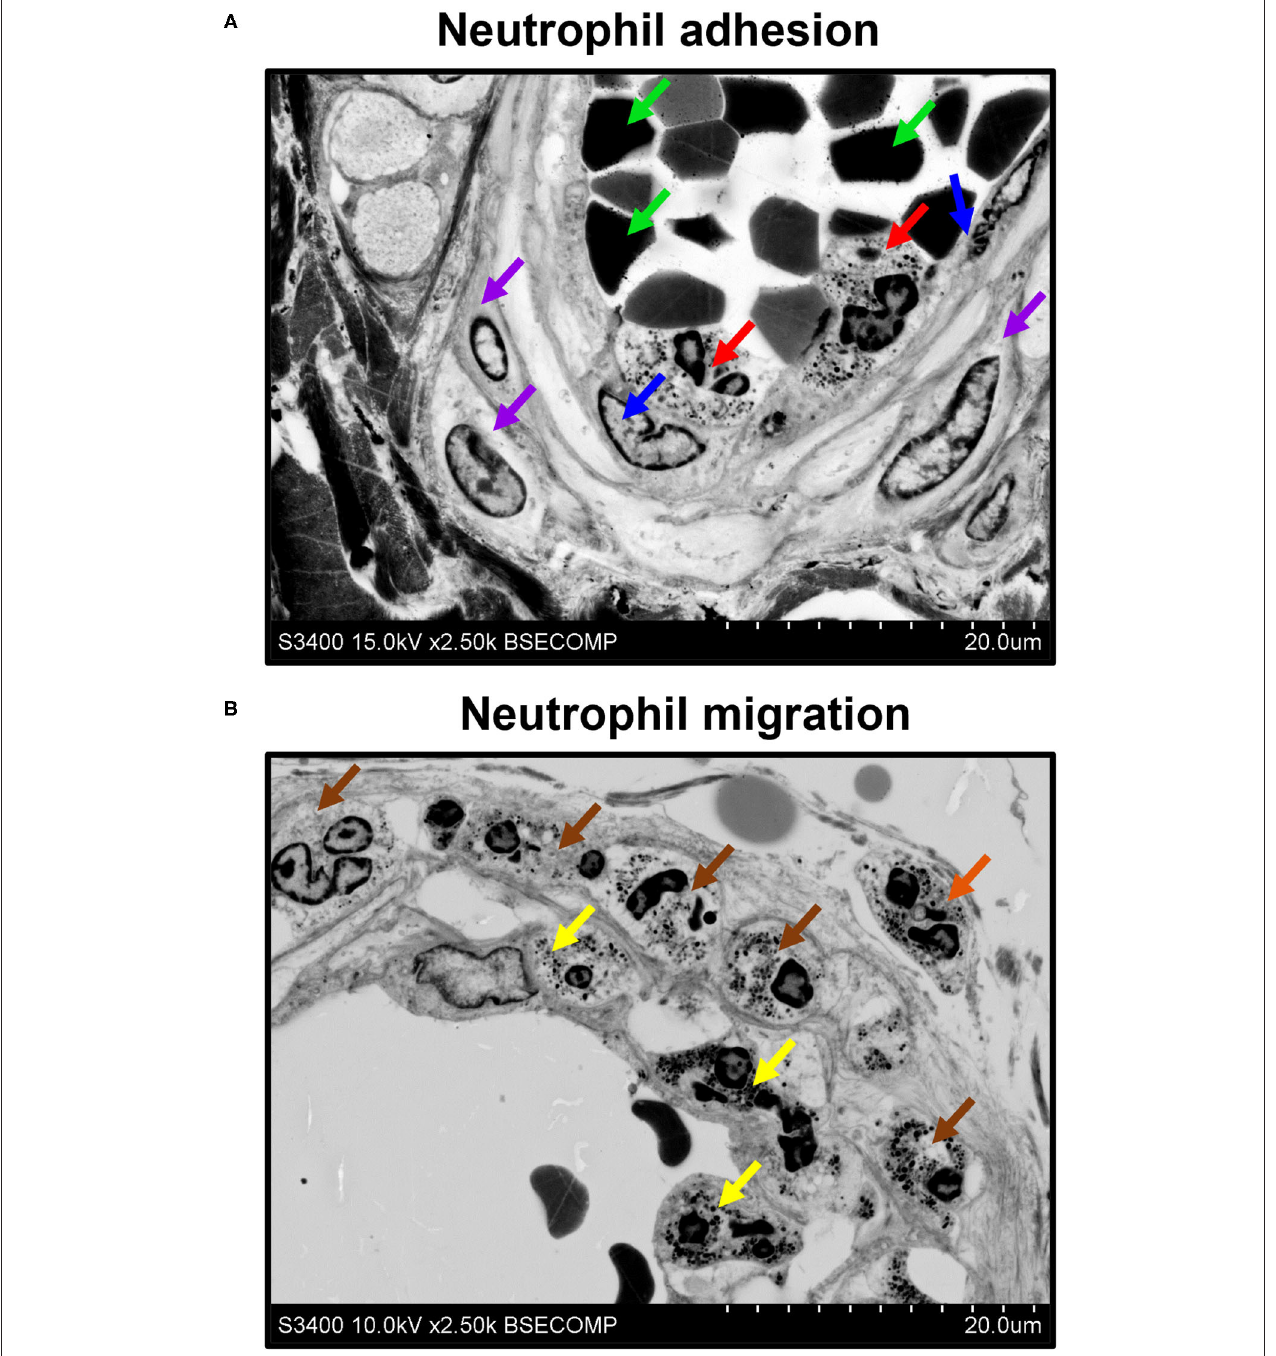
FIGURE 9 | EM-BSEM visualisation of neutrophil adhesion and migration. Left internal mammary artery excised for coronary artery bypass graft surgery purposes. (A) Note the neutrophils (indicated by red arrows) adhering to endothelial cells (indicated by blue arrows). Red blood cells and vascular smooth muscle cells are indicated by green and violet arrows, respectively. (B) Note adhering neutrophils (indicated by yellow arrows), invading neutrophils (indicated by brown arrows), and migrating neutrophils (indicated by an orange arrow). A magnification of × 2,500 (scale bar: 20 µ m) and accelerating voltage of 15 kV (upper image) and 10 kV (lower